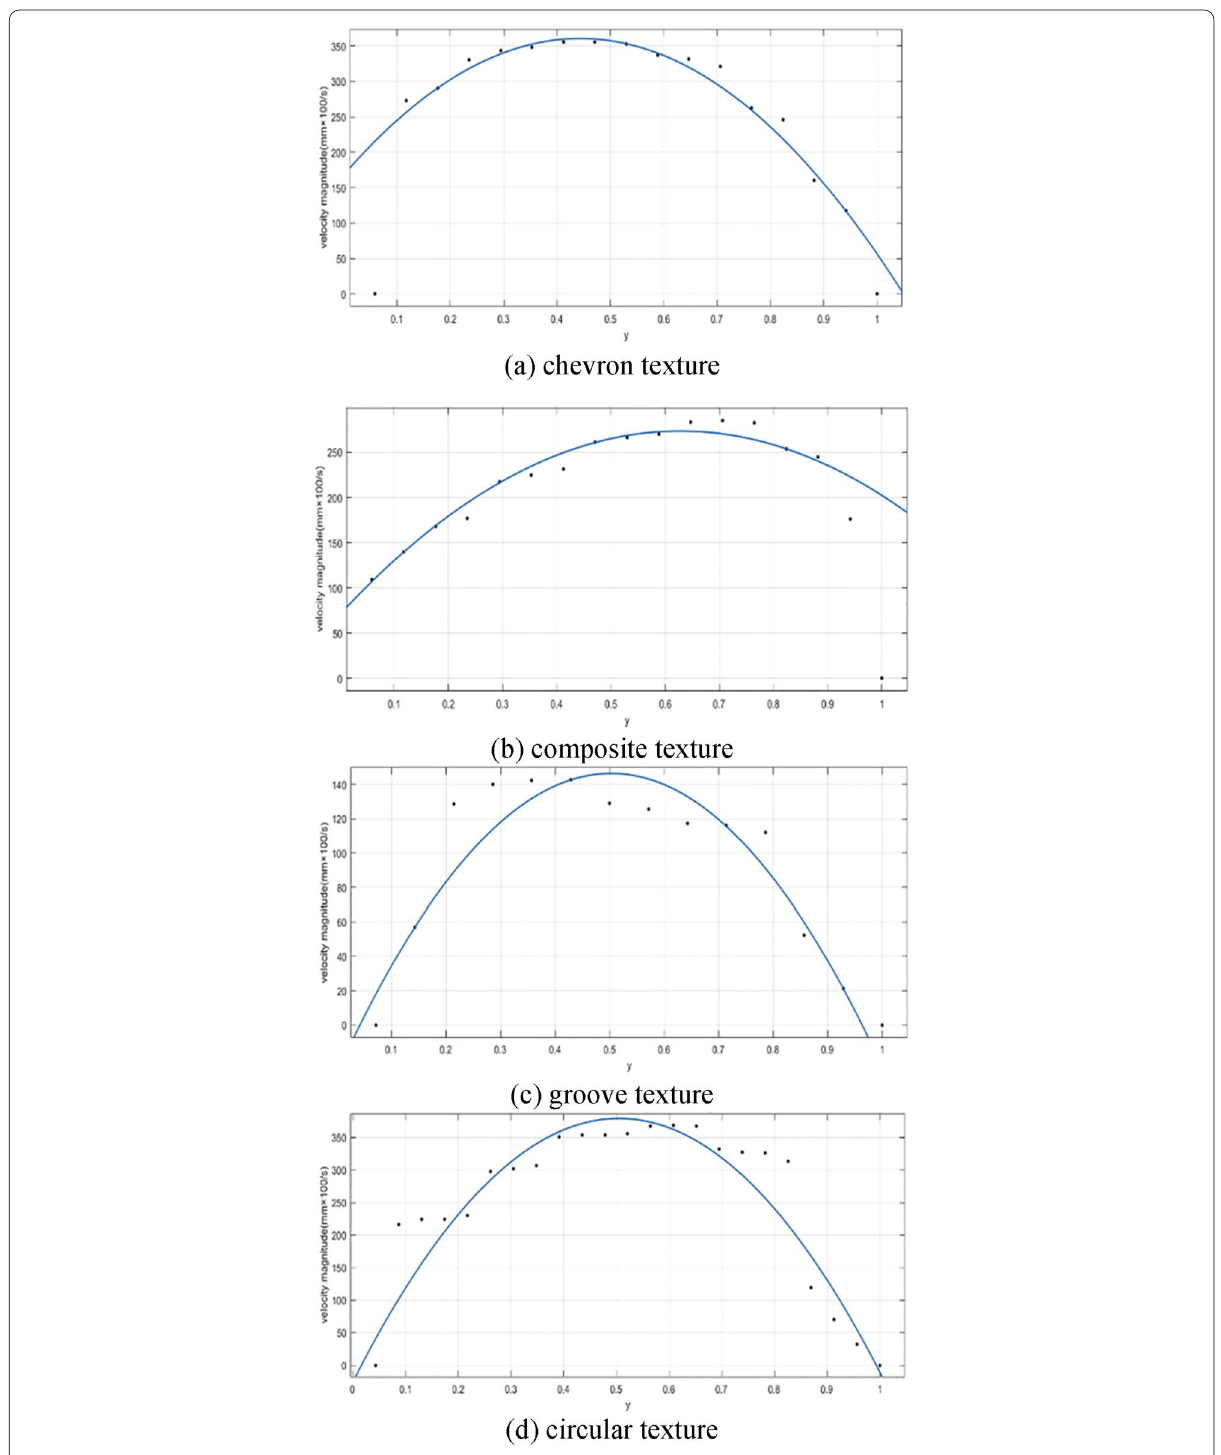
Figure 7 Fitting curves of four